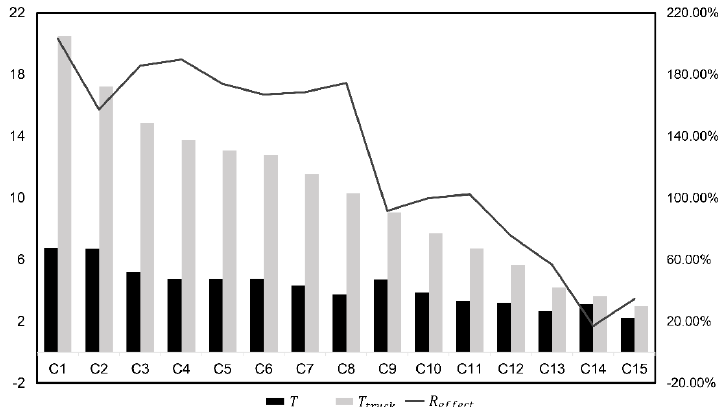
Figure 7. Efficiency of the algorithm.